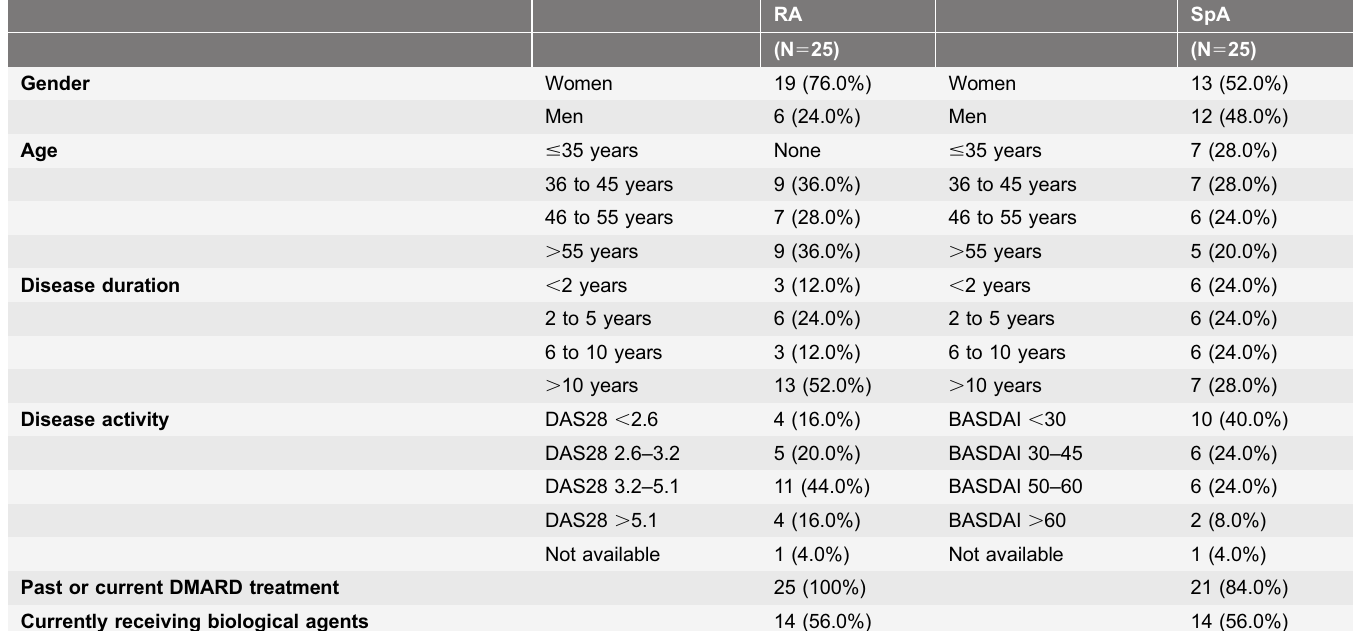
Table 1. Patient